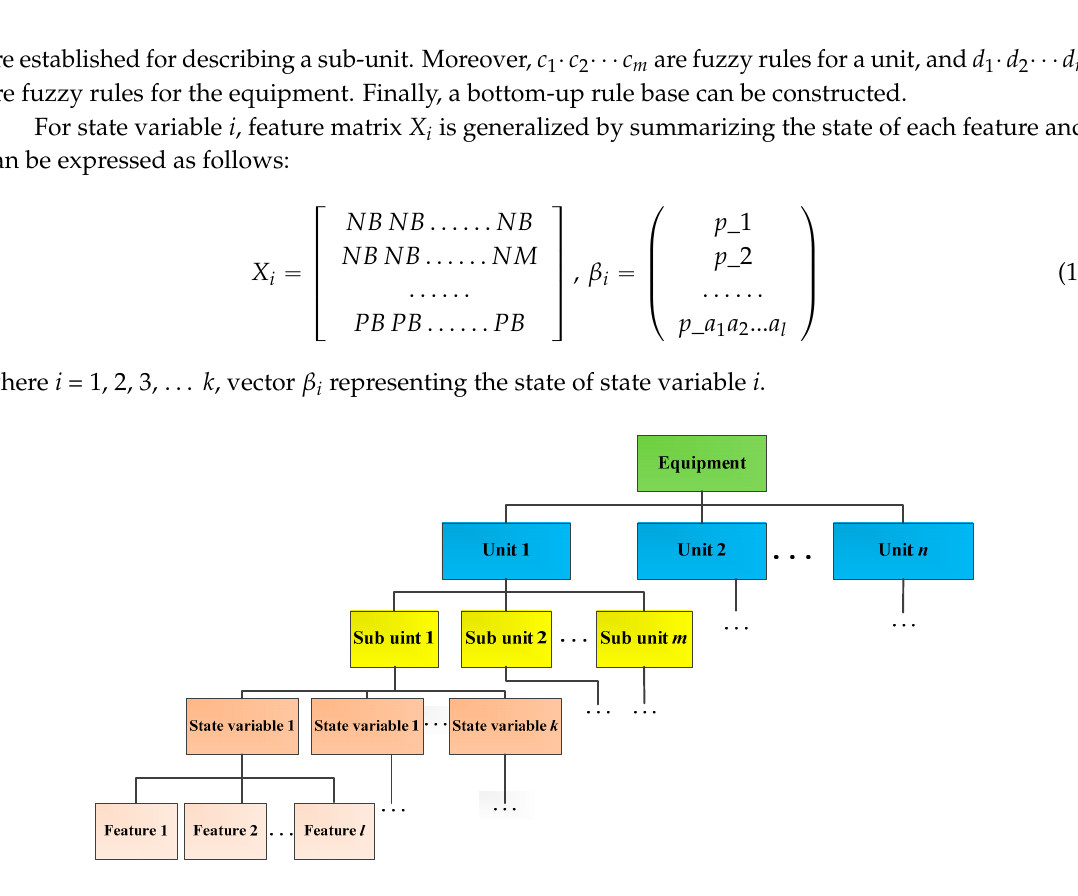
Figure 1. Multi-level state space for the complex equipment.